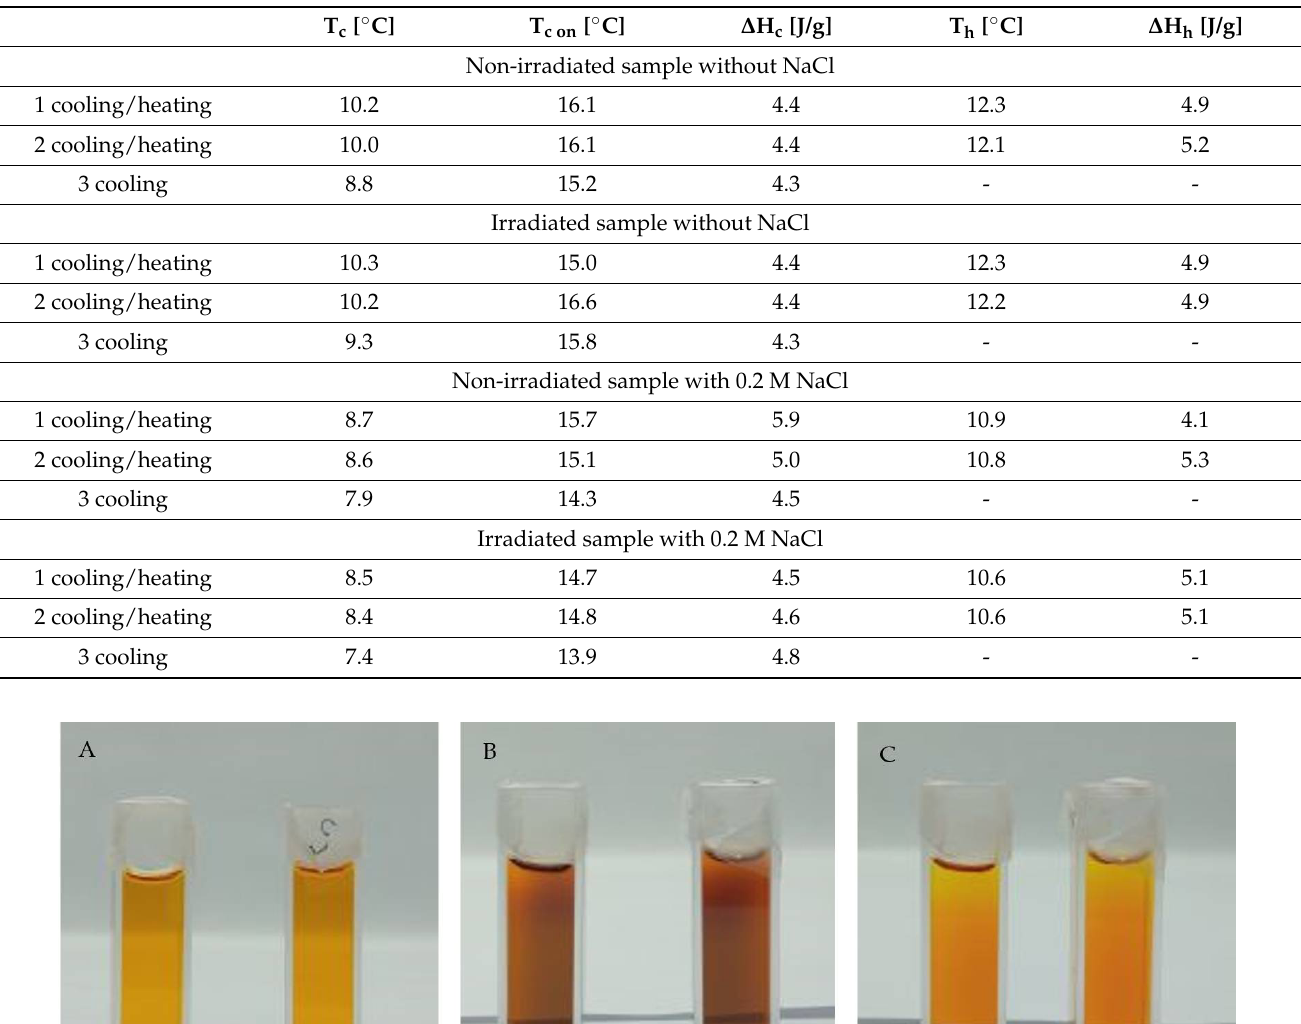
Table 1. DSC measurement results of the irradiated (30 Gy, 6 MeV electrons) and non-irradiated Fricke-XO-Pluronic F-127 with and without NaCl for heating and cooling. T c or T h is the temperature at which the maximum thermal effect occurs, ∆ H denotes the enthalpy change, c is for cooling, on is for onset (initial phase of a phase transition process), and h is for heating.